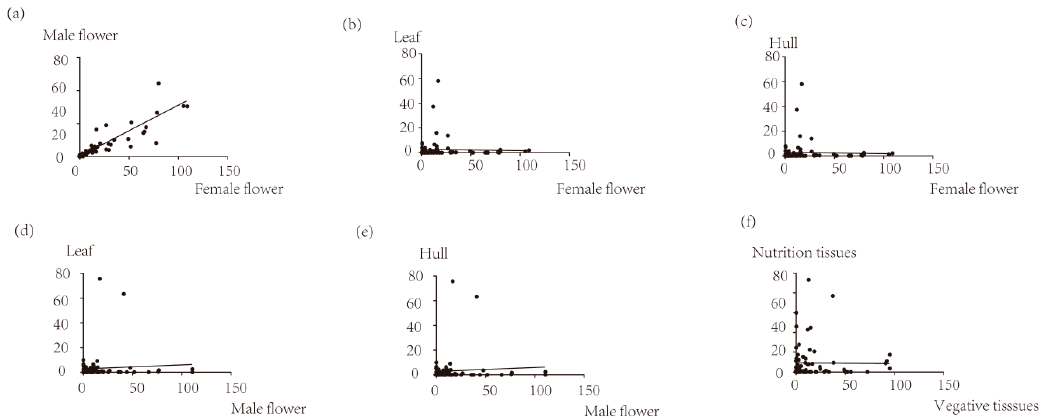
Figure 6. The regression analysis of the F-box gene family of common walnut.( a ) the regression analysis of expression level between male and female flower; ( b ) the regression analysis of expression level between leaf and female flower; ( c ) the regression analysis of expression level between hull and female flower; ( d ) the regression analysis of expression level between leaf and male flower; ( e ) the regression analysis of expression level between hull and male flower; ( f ) the regression analysis of expression level between nutrition tissues and vegative tissues. Forests 2019 , 10 , x FOR PEER REVIEW